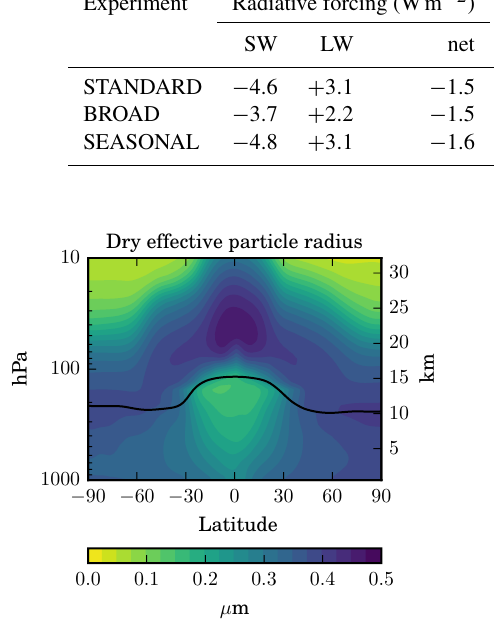
Figure 4. Latitude–height cross section of the zonal and annual mean effective radius (in µm) of dry sulfate particles in the STAN- DARD experiment. The effective radius is computed from the zonal and annual means of the aerosol volume and surface area.